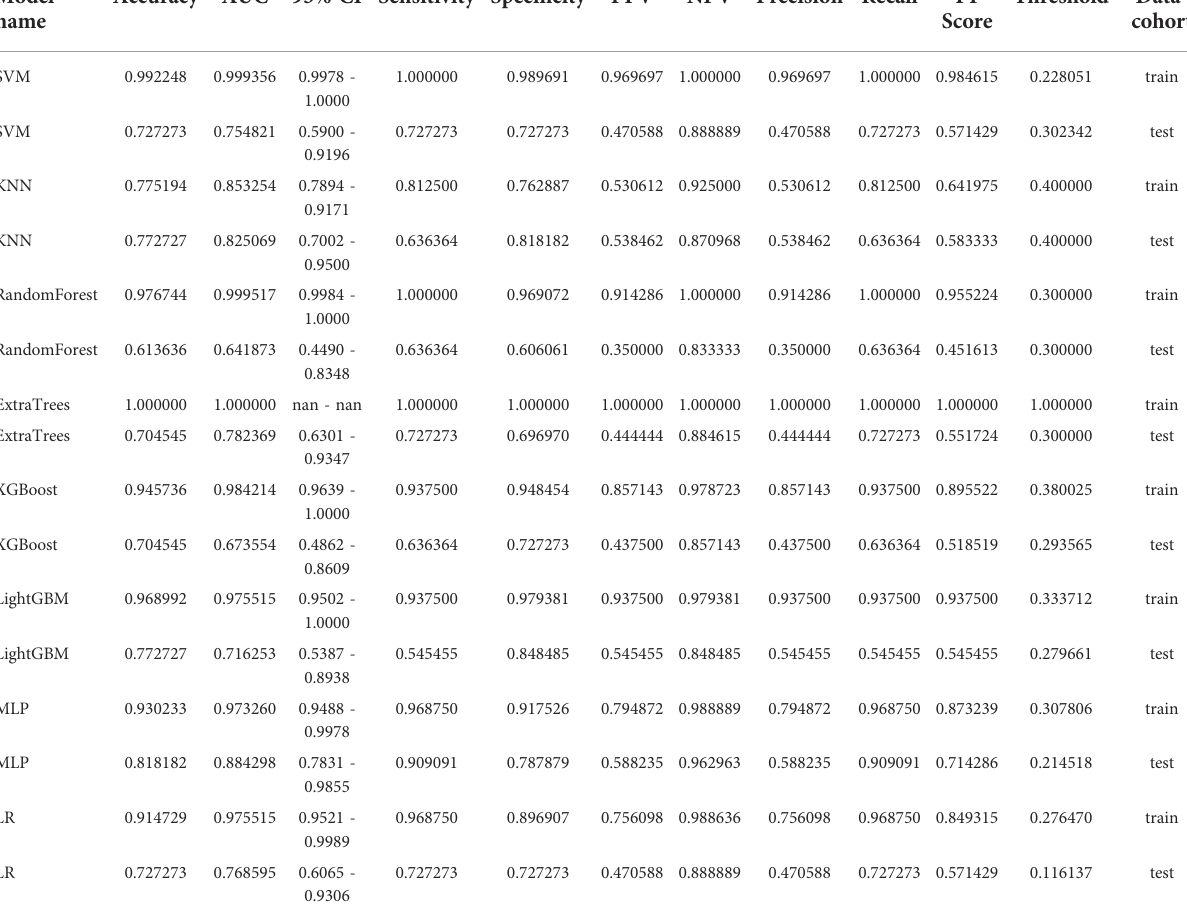
TABLE 3 Performance of the machine learning in the training and testing cohorts. Model